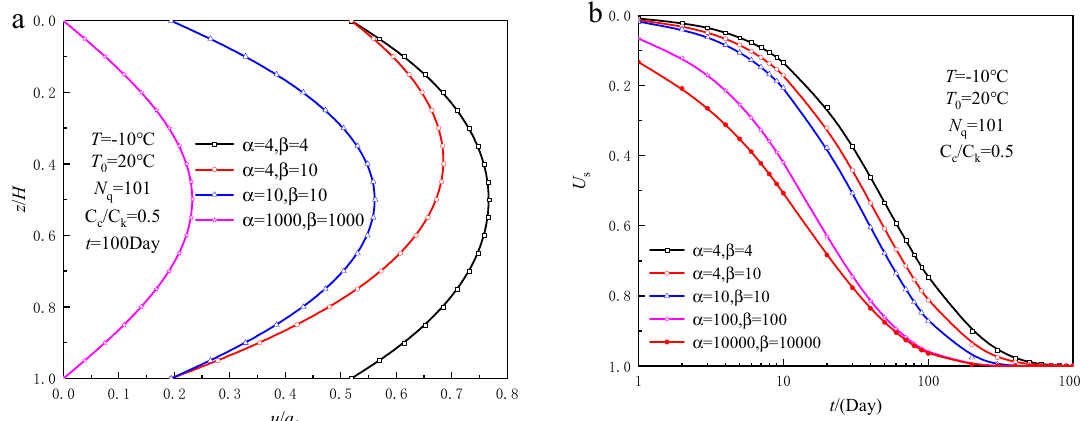
Figure 8. Influence of the interface parameters: ( a ) the distribution of excess pore water pressure, and ( b ) the distribution of the degree of the consolidation defined by settlement.